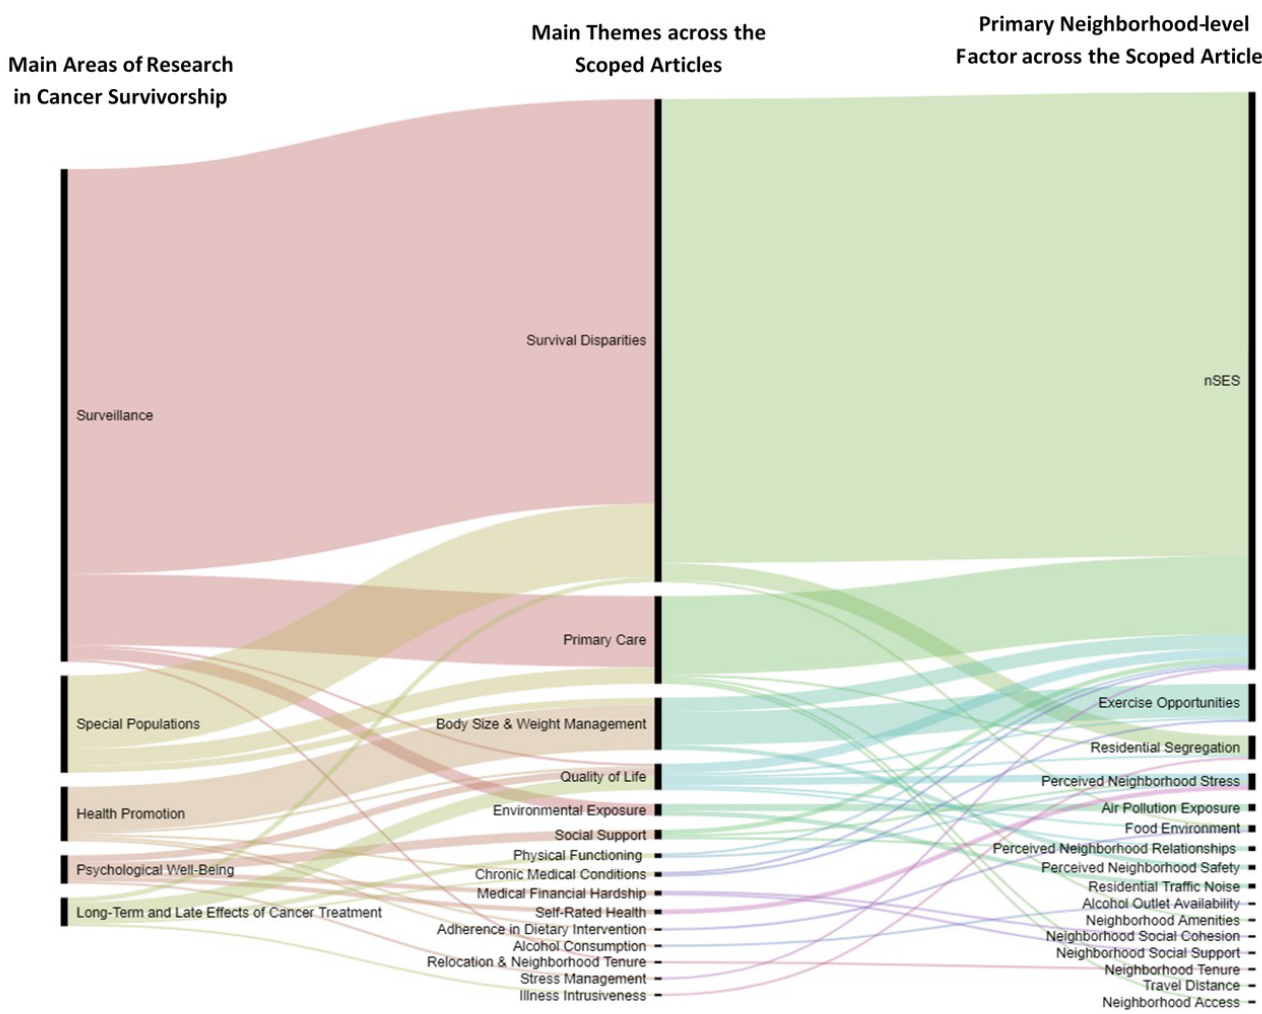
Figure 2. Main themes and primary neighborhood factors across the scoped articles.